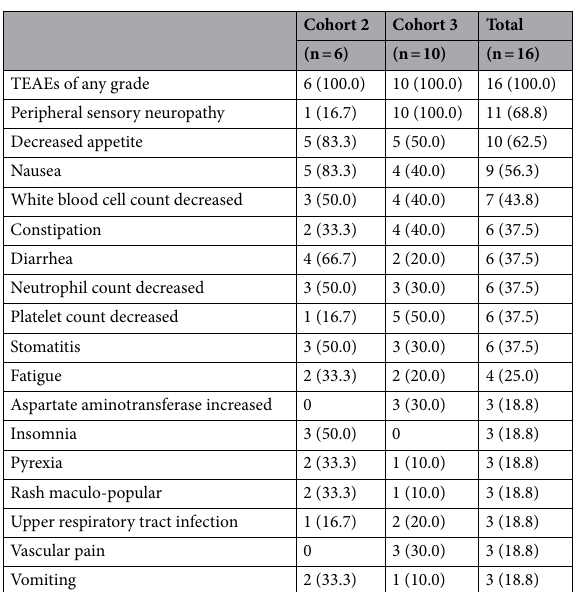
Table 2. Treatment-emergent adverse events (TEAEs) of any grade observed in ≥ 15% of all patients. The safety analysis set includes subjects who received at least one dose of ADX. Treatment-emergent adverse events (TEAEs) are AEs with onset dates on or after the first dose of study drug ADX and up to 30 days after permanent withdrawal of ADX.